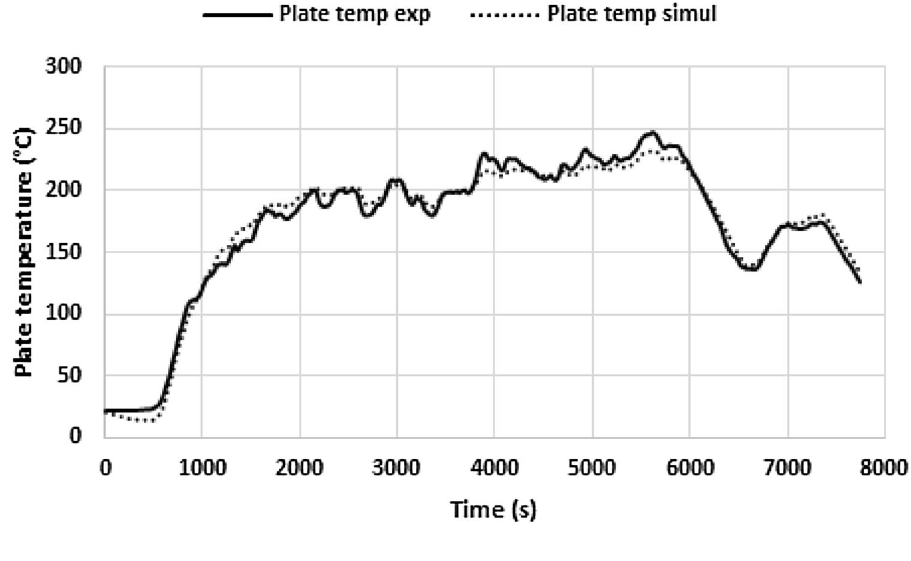
Fig. 10 Experimental (solid line) and simulated (dotted line) plate temperature along the combustion experiment with the plate configuration